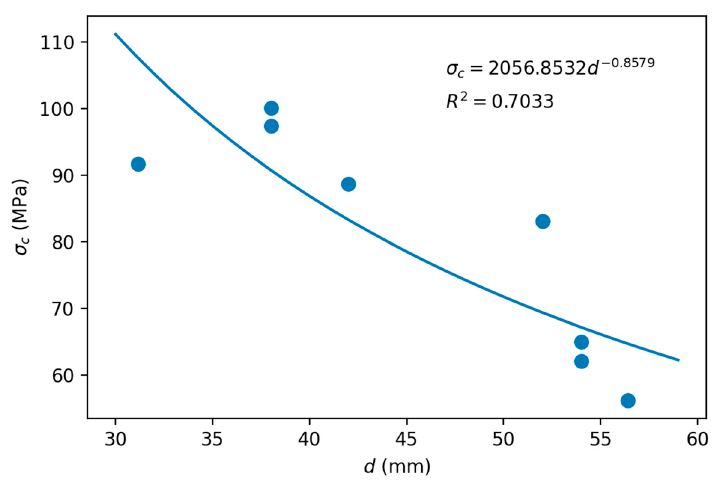
Figure 11. Least squares adjustment to estimate the σ c (50) of the travertine scale effect.